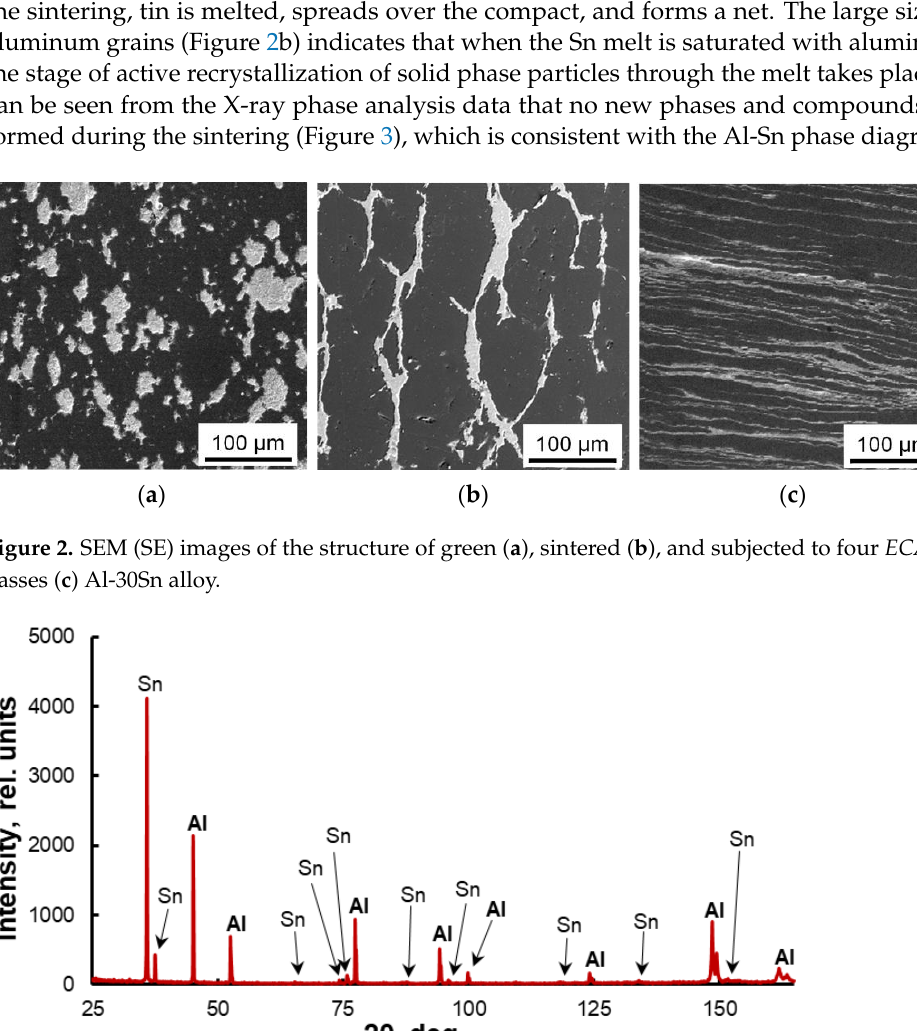
Figure 1. Sample processing scheme in the die for ECAP ( a ) and scheme pin-on-disk of the wear tests ( b ).